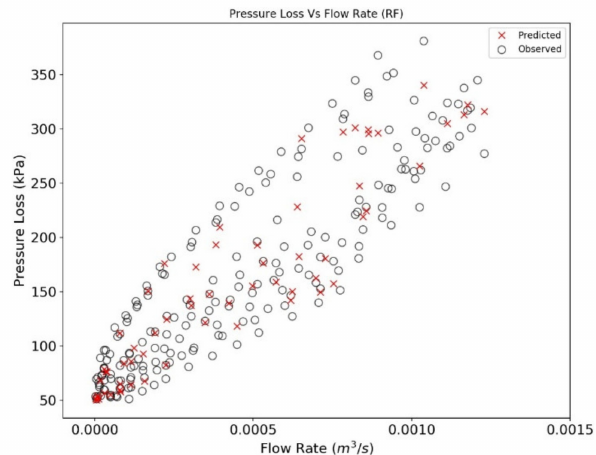
Figure 13. Observed and predicted pressure loss is plotted with flow rate for RF algorithm for high pressure regime.